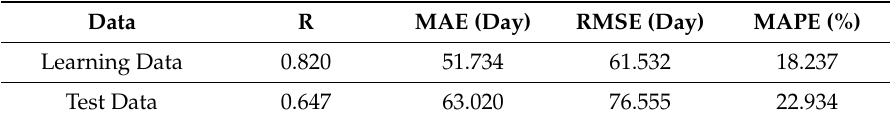
Table 6. Average results of the model learning and test.